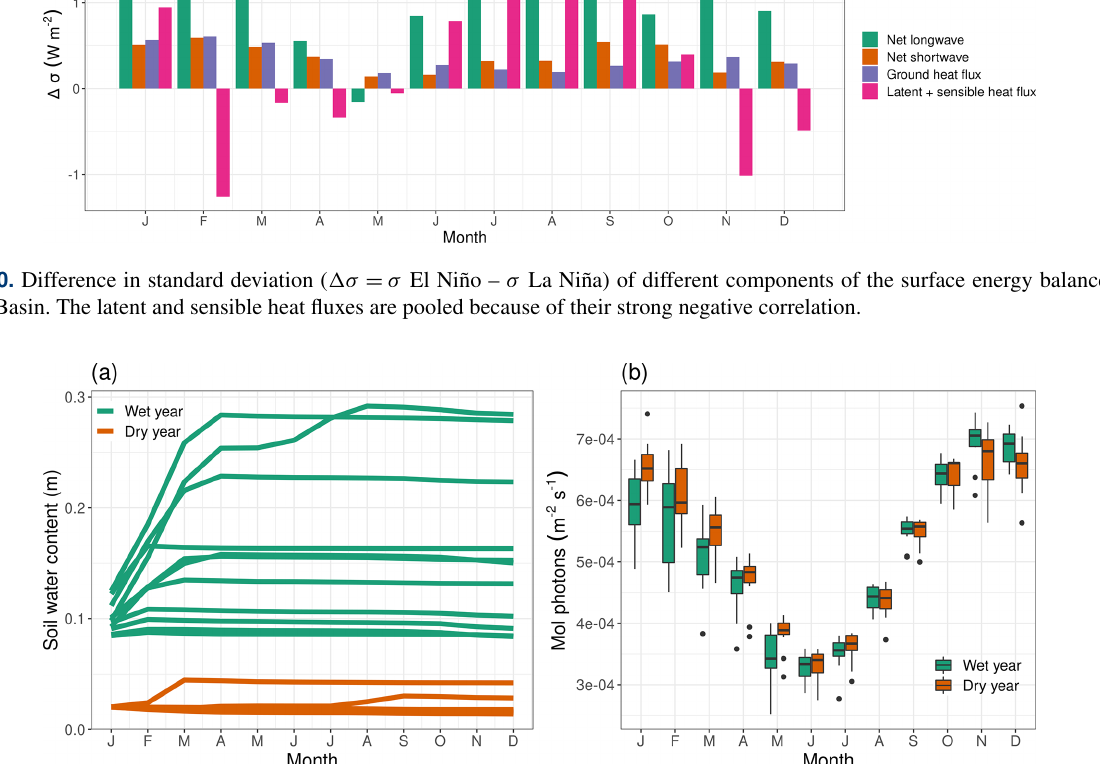
Figure 11. Difference in ensemble member spread in northwestern Australia between a wet and a dry year for (a) deepSOIL and (b)